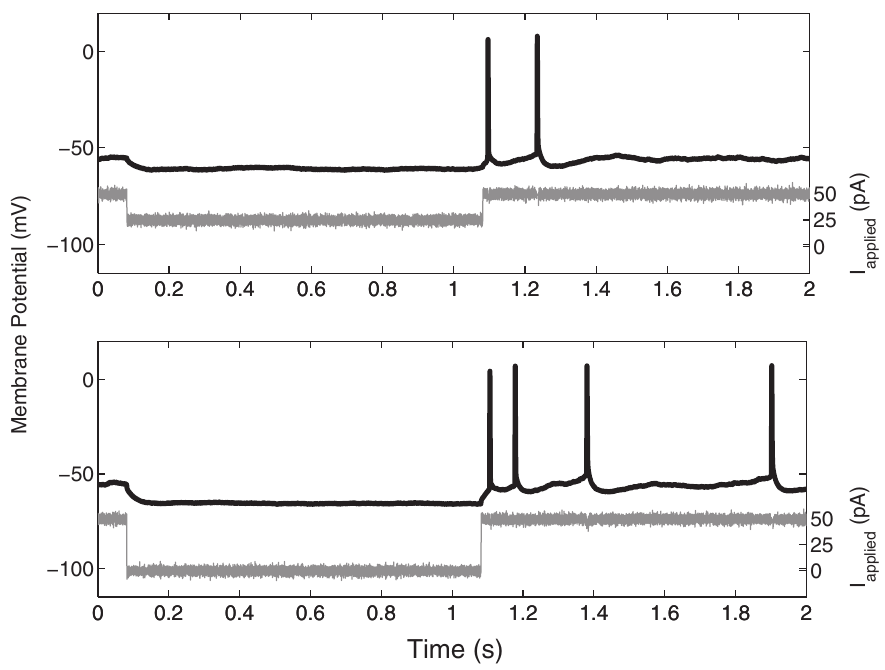
Figure 1. An example of rebound firing in a CA1 pyramidal cell. While the cell was held at -52 mV in current clamp, two 1-s hyperpolarizing steps (shown in grey; top: 25 pA, bottom: 50 pA) were used to record the post-hyperpolarization rebound spiking (voltage traces shown in black). For visualization purposes, the spike artifact in the current clamp input trace was removed and replaced with the mean